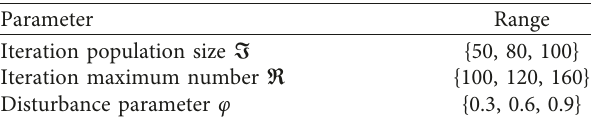
Table 4: Testing scope of three